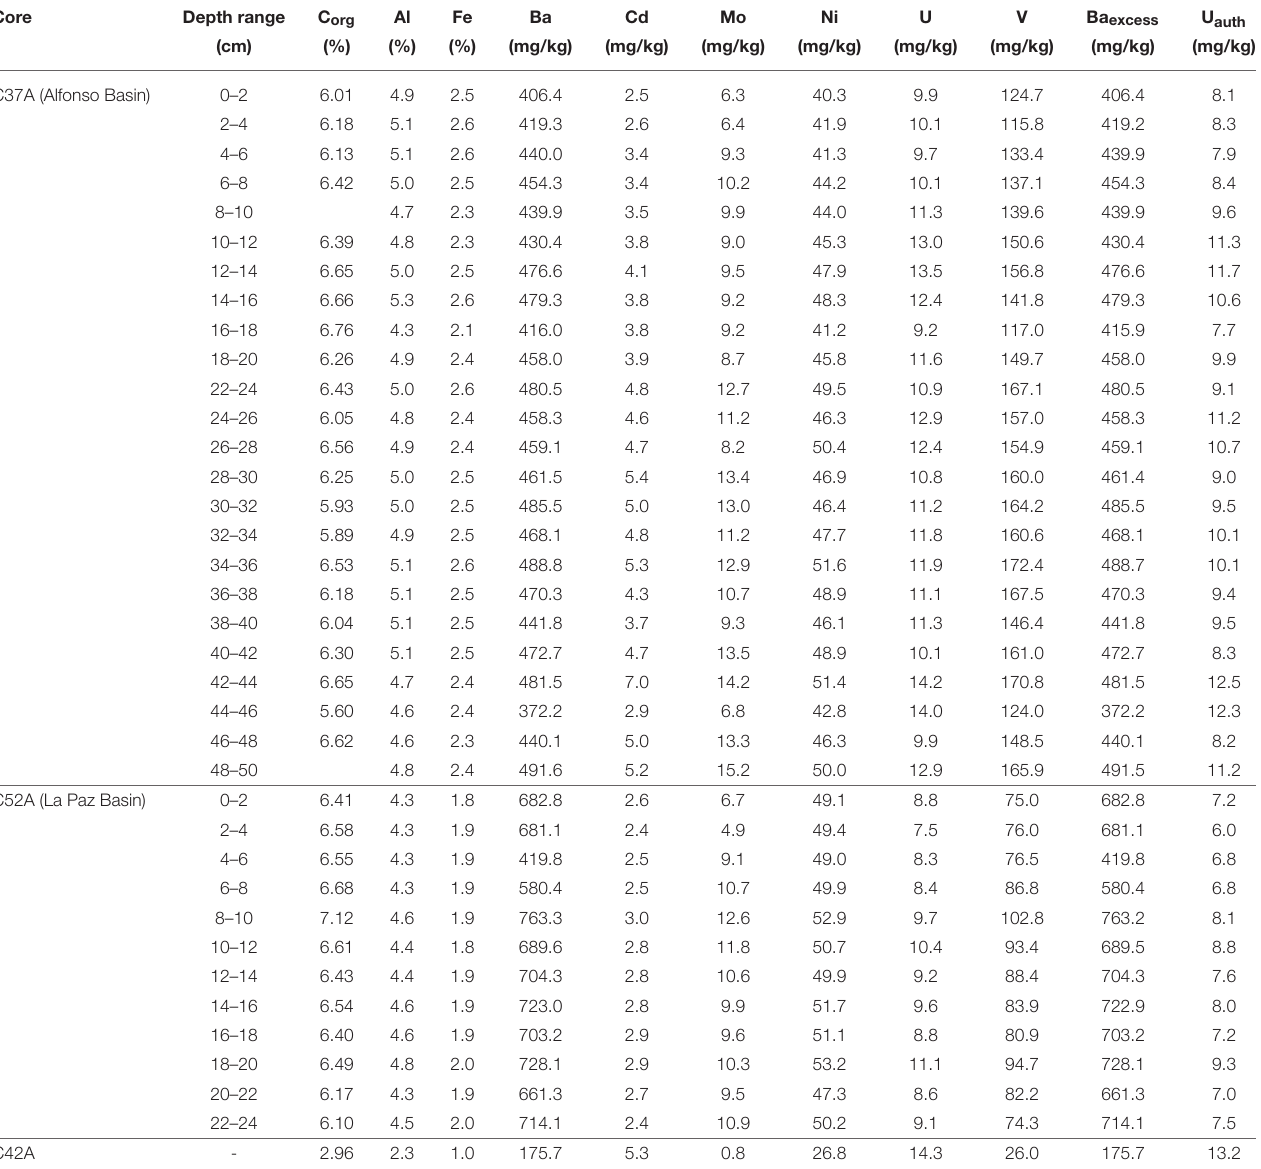
TABLE 3 | Elemental composition of the solid phase from cores C37A, C42A, and C52A collected during PALEOMAR-I expedition to the Gulf of California.